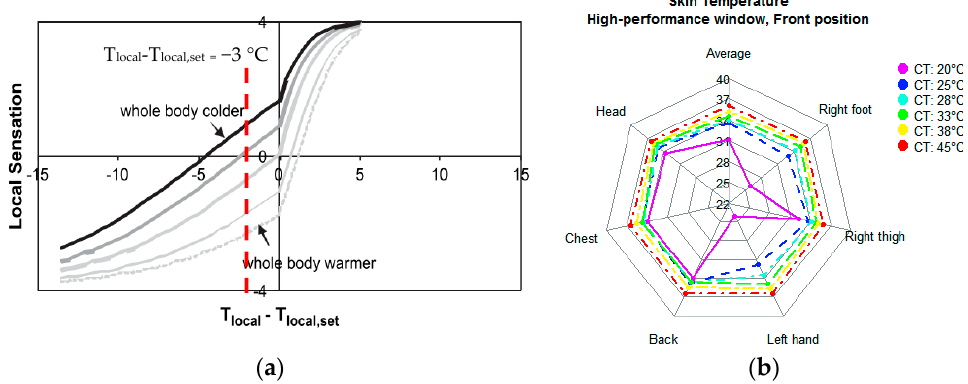
Figure 16. ( a ) Local thermal sensation state as a function of overall body thermal state and local skin temperature (°C) [26]. ( b ) Presentation of local skin temperatures at different ceiling temperatures as an example from other scenarios.